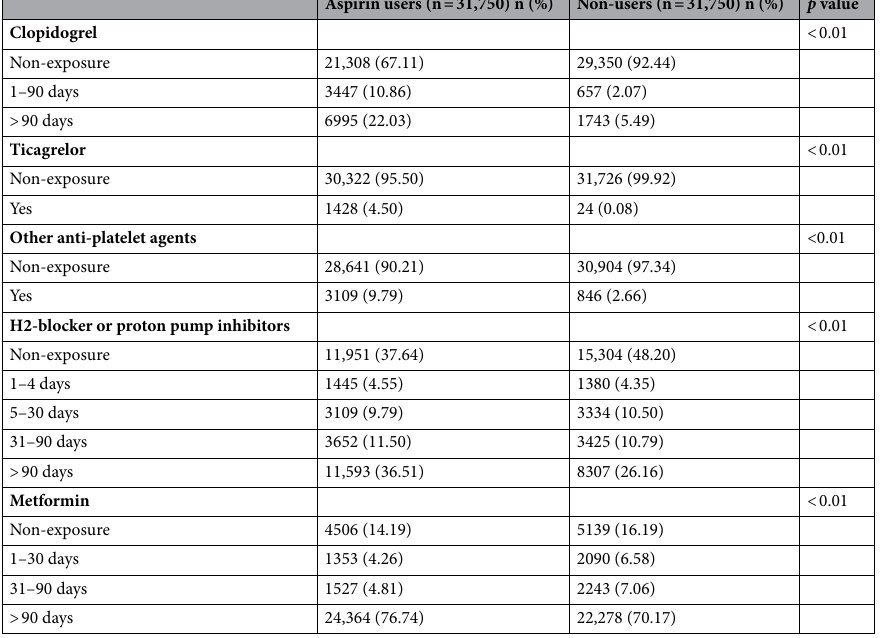
Table 2. Concomitant medications used during follow-up in the matched